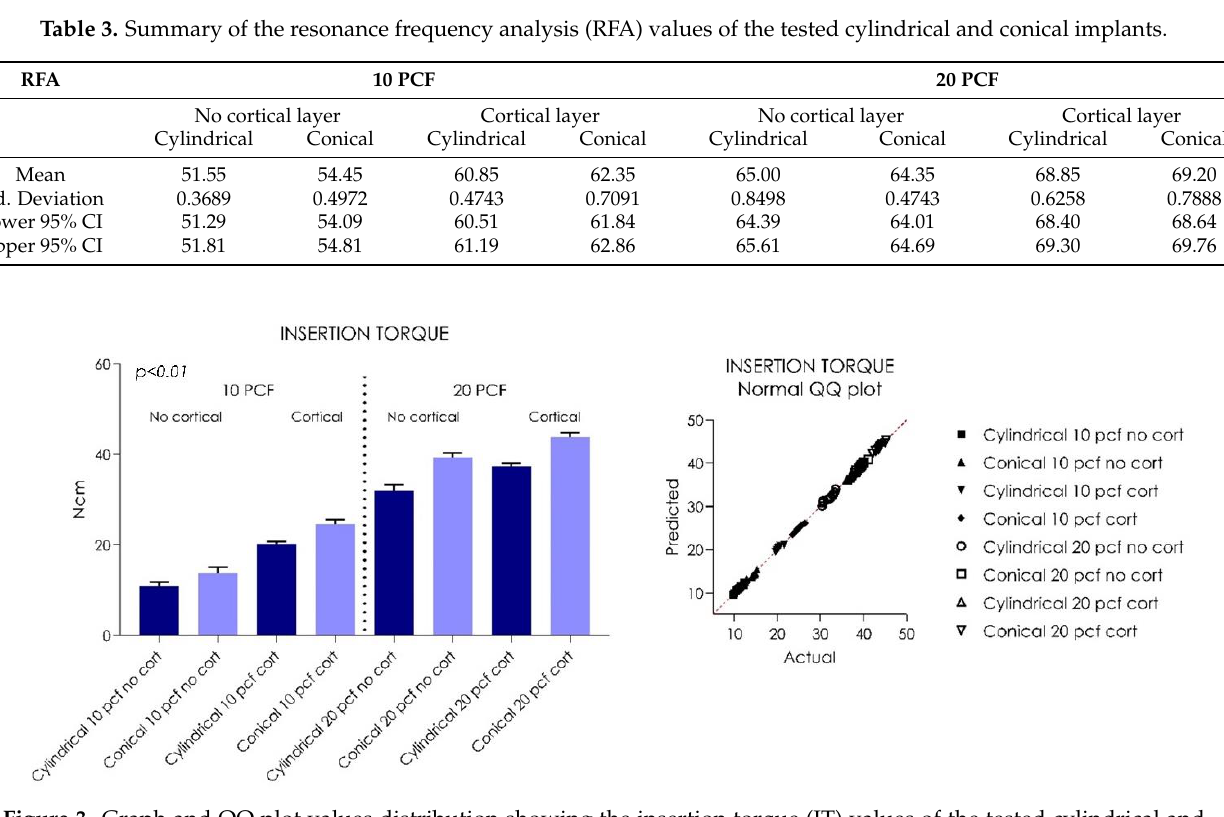
Table 3. Summary of the resonance frequency analysis (RFA) values of the tested cylindrical and conical implants.